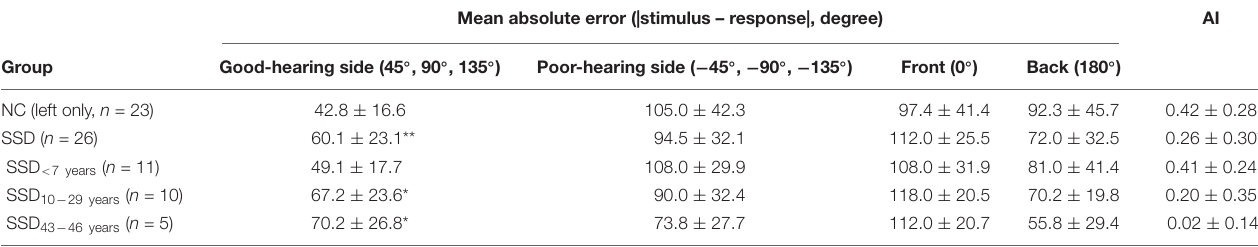
FIGURE 2 | Sound localization test results. Response angles were plotted by stimulation angle in the acutely plugged NC (A) and SSD (B) groups. Both groups showed response bias toward the intact (open) ear side. Upon all responses, 68.2 and 67.3% were recorded on the intact ear side in the simulated NC and SSD groups, respectively. TABLE 2 | Mean absolute error values in four directions and asymmetry index values in the SSD and NC groups (mean ± SD). Mean absolute error (|stimulus – response|,